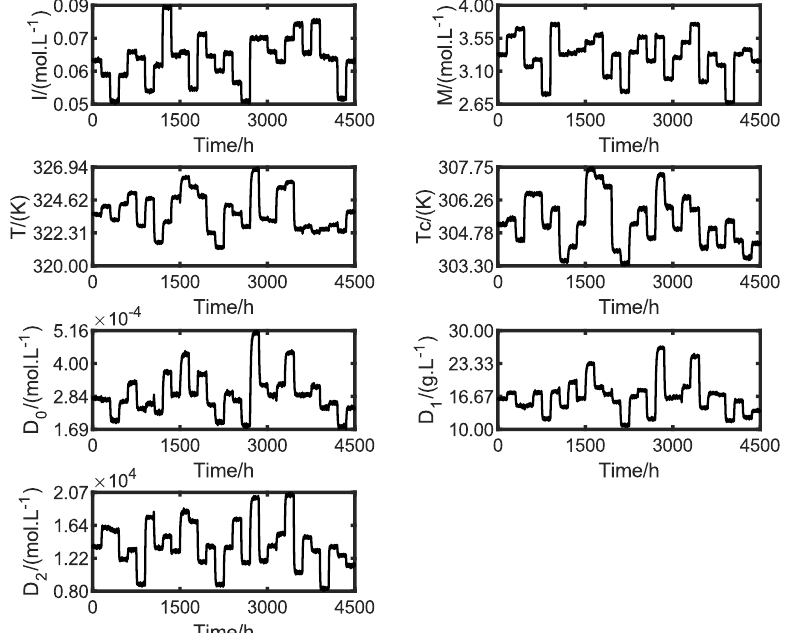
Figure 8. Synthetic output data with white